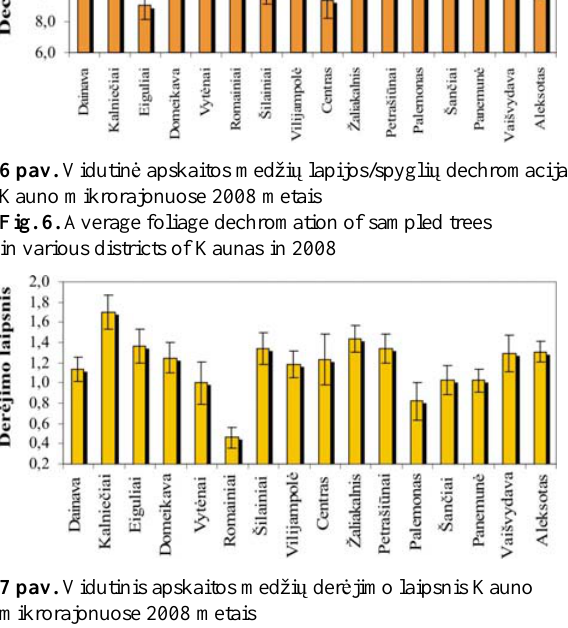
Fig. 7. Average fruiting rate of sampled trees in various districts of Kaunas in 2008